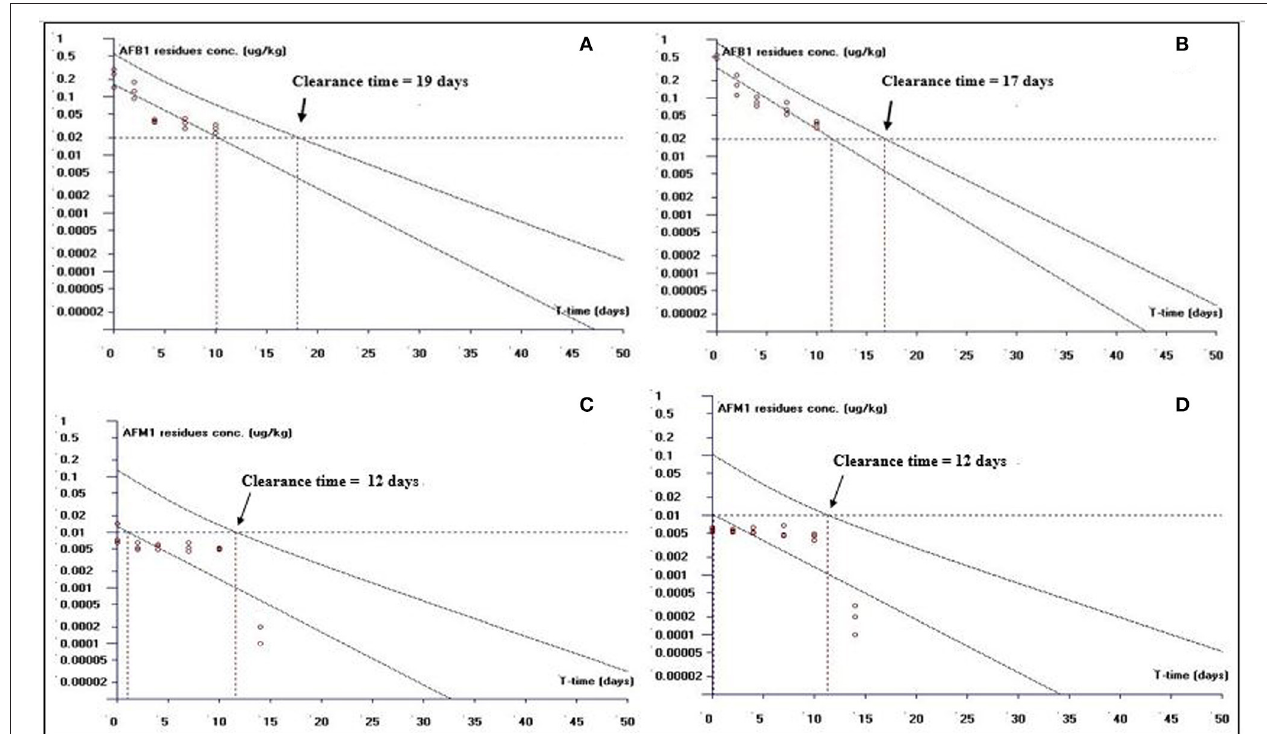
FIGURE 3 | The representative semi-logarithmic plot shows aflatoxin B1 (AFB1) and aflatoxin M1 (AFM1) residue concentrations for broiler muscles tissues vs. time , with the one-sided 95% upper tolerance limit in AFB1-fed group; (A) AFB1 residues (C) AFM1 residues and in curcumin + AFB1-fed group; (B) AFB1 residues (D) AFM1 residues. Small circles represent the residue concentrations of AFB1 and AFM1 for individual broiler chicken. The clearance period calculation based on the limit of quantification (LOQ; 0.02 µ g/kg for AFB1 and 0.01 µ g/kg for